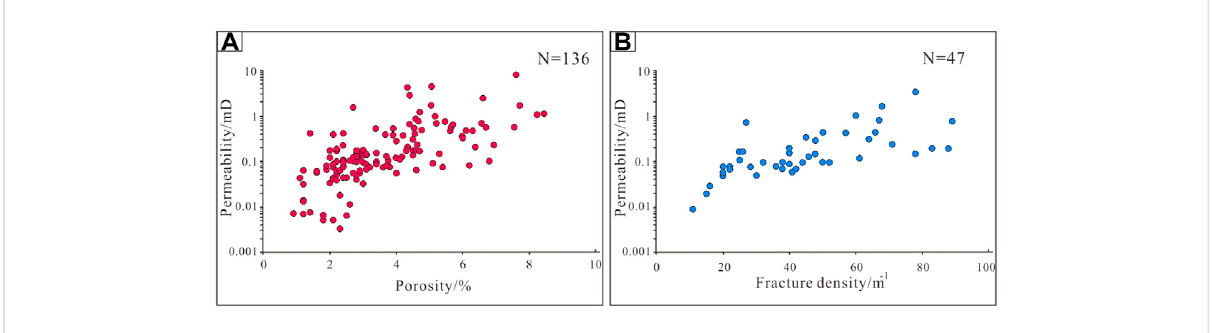
FIGURE 14 Physicalpropertyrelationshipsofburiedhillreservoircoresamplesinthestudyarea. (A) Therelationshipbetweenporosityandpermeability; (B) The relationship between permeability and fracture linear density).